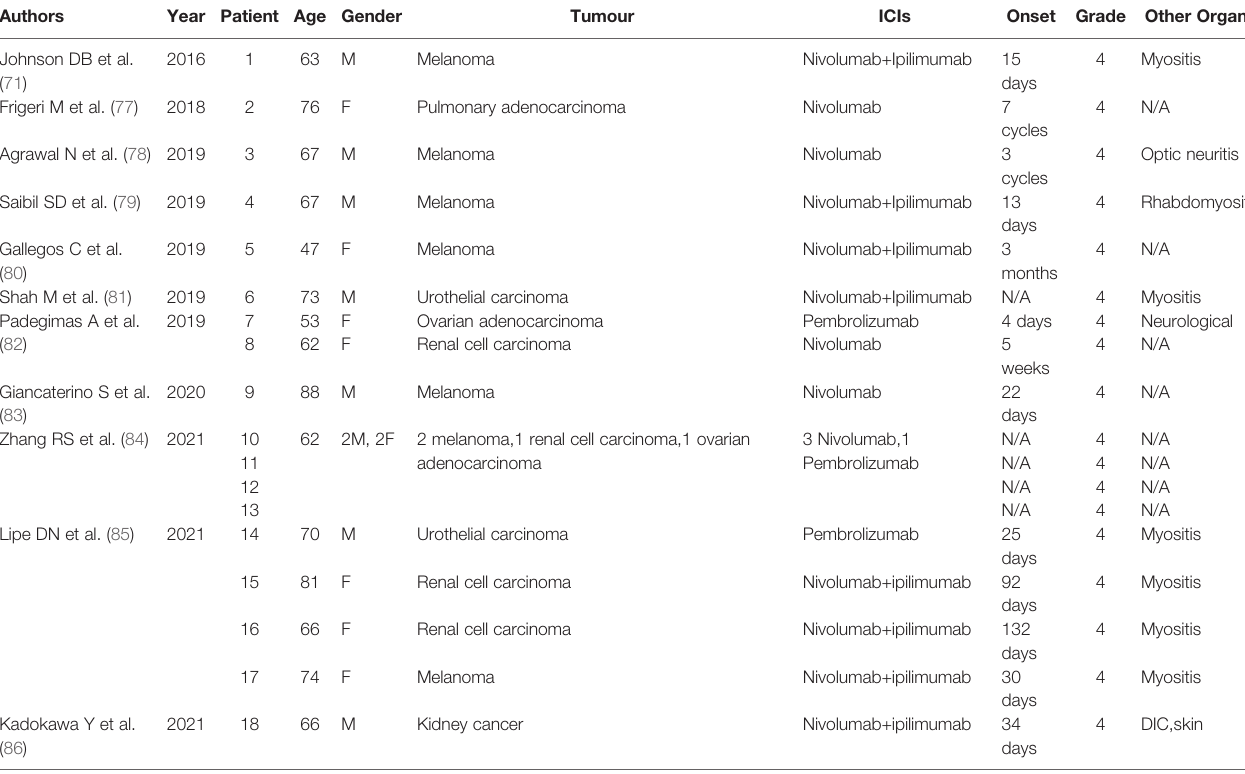
TABLE 1 | Articles using anti-TNF-therapy for ICI-induced